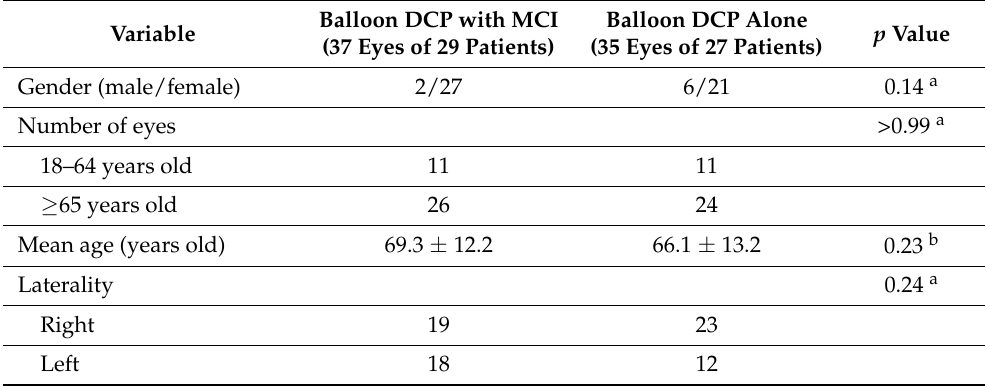
Table 1. Demographic data in patients in balloon DCP combined with pushed-type MCI group and balloon DCP alone group.